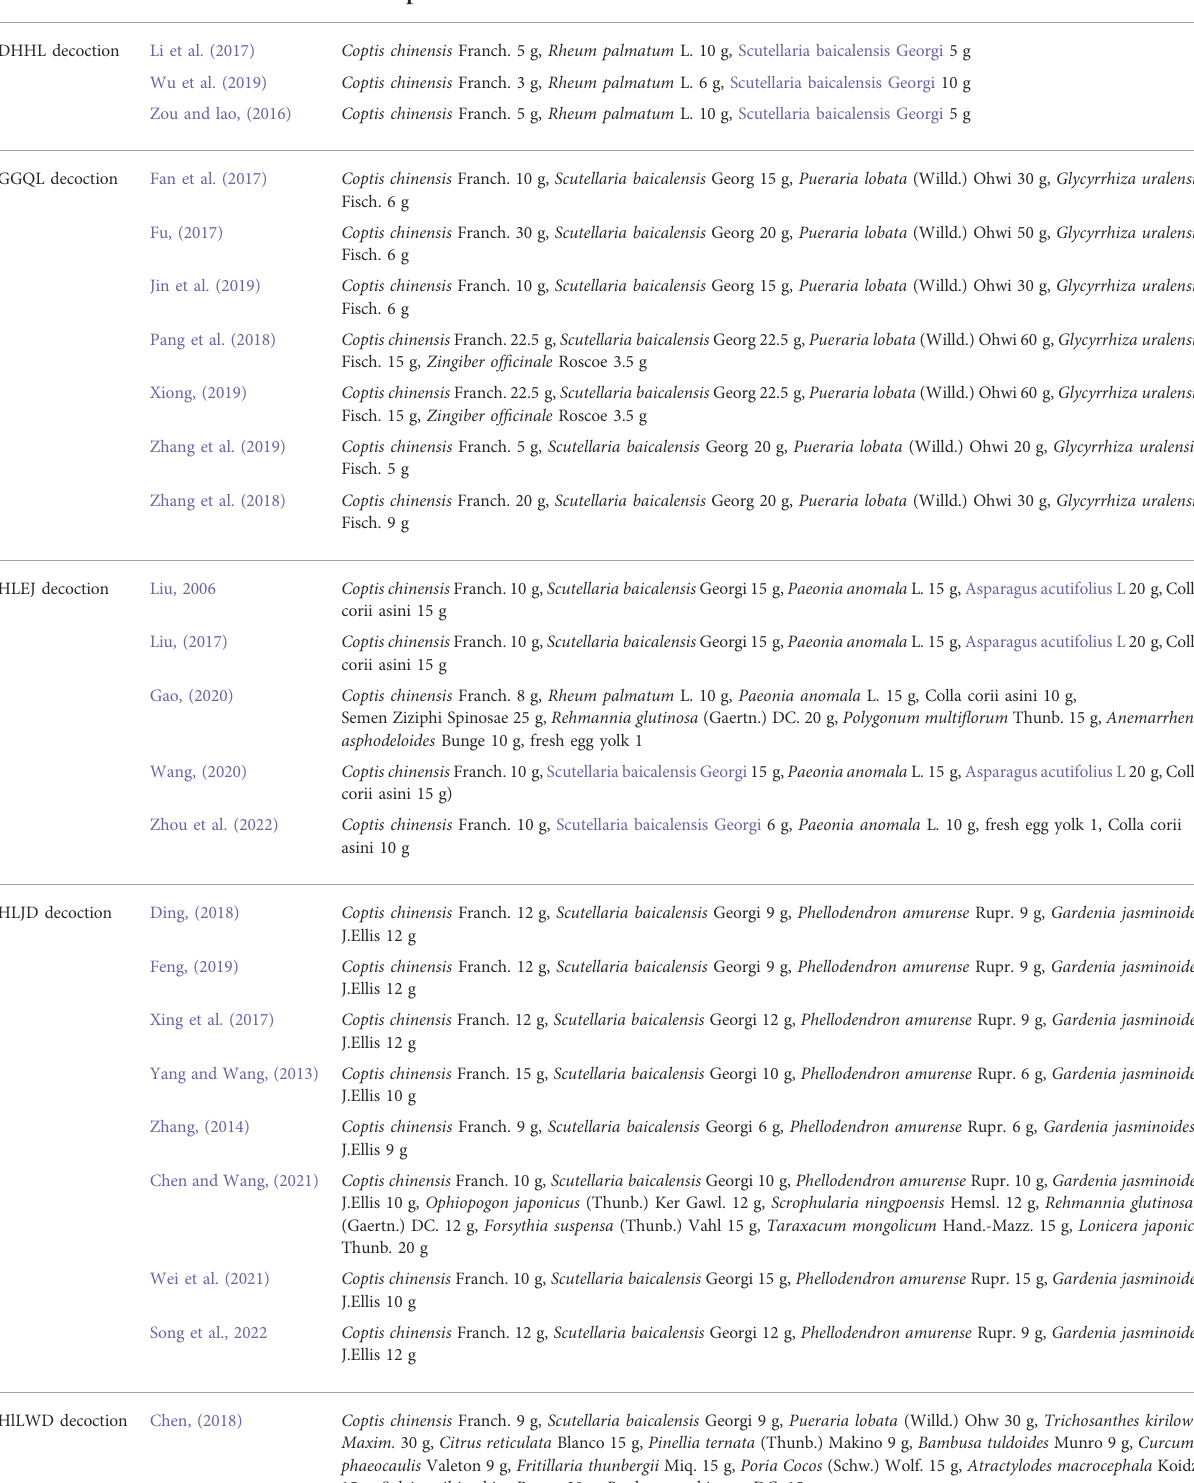
TABLE 2 Details of the HLPs for each study.